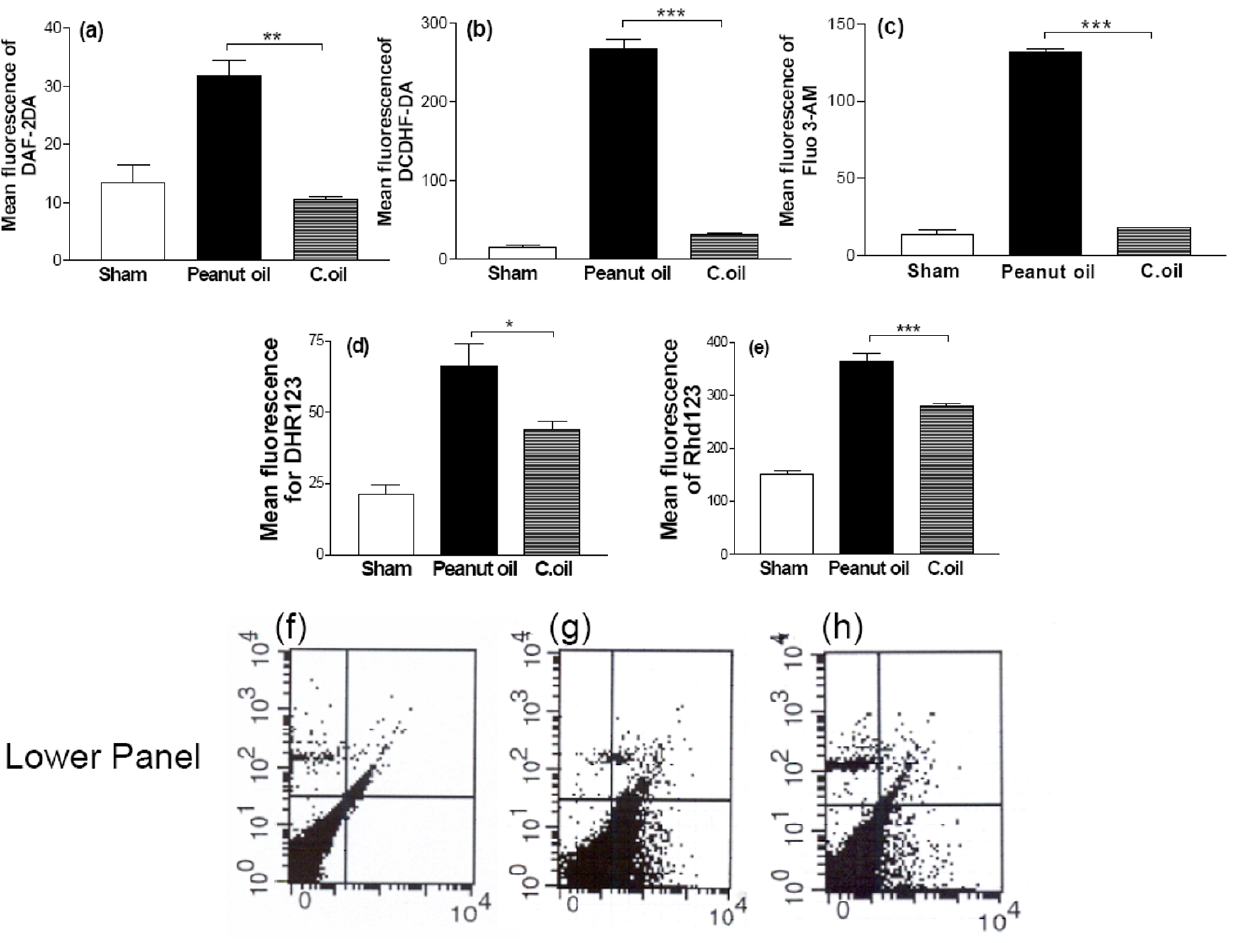
Figure 6 Flowcytometric estimation of neuronal rich cell population from sham-operated, peanut oil treated ischemic and C.oil treated groups were euthanized at 24 hrs. Brain neuronal rich cell population were loaded with different fluorochromes for the estimation of neuronal Reactive Oxygen Species (ROS), Nitric oxide (NO), Peroxynitrite (ONOO - ), mitochondrial membrane potential ( ΔΨ m), intracellular calcium level and quantification of cell death type. Mean fluorescence of neurons (10 6 /ml) were acquired for quantification and analyzing in cell quest program of Becton Dickinson Flowcytometer. Data are expressed as mean fluorescence ± S.E.M P < 0.001 was considered highly significant when comparisons were made with the peanut oil treated ischemic group by one way ANOVA followed by Newman Keuls post hoc test. Five rats per group were used. (a): Nitric oxide from neurons (10 6 /ml) were estimated using Diaminofluoresceindiacetate (DAF-2DA). (b): ROS were estimated from neurons (10 6 /ml) using the mean fluorescence of DCDHF-DA. (c): Measurements of intracellular calcium from neurons (10 6 /ml) were estimated using, fluorescence of Fluo-3AM. (d): Peroxynitrite was estimated from neurons (10 6 / ml) using the mean fluorescence of DHR 123. (e): For estimation of mitochondrial membrane potential the mean fluorescence of Rhod 123 obtained from neurons (10 6 /ml). Lower panel: Representative dot plots for quantification of mode of death, the mean florescence, from neuron using FITC- conjugated Annexin V and Propidium iodide (PI). Neurons (10 6 /ml) were obtained from sham-operated (f), peanut oil treated ischemic (g) and C.oil post-treatment ischemic (h) groups of rats; lower left quad- rant shows viable cells (Annexin V negative and PI negative), lower right quadrant shows early apoptosis (Annexin V positive and PI negative, Upper right quadrant shows late apoptotic/necrotic cells (Annexin V positive and PI positive) and upper left quadrant shows necrotic cells (Annexin V negative and PI